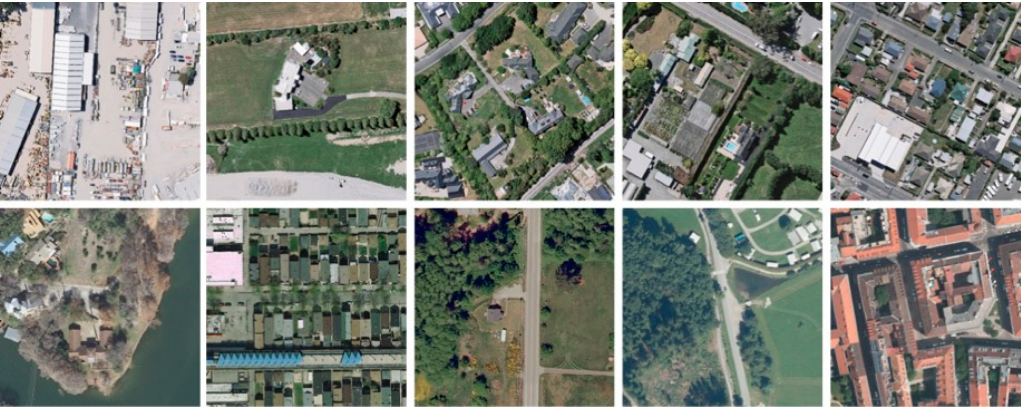
Figure 3. Visual close-ups of the WHU aerial dataset and the INRIA dataset. Images of the first (second) row are randomly selected from the training set of the WHU (INRIA) aerial dataset.